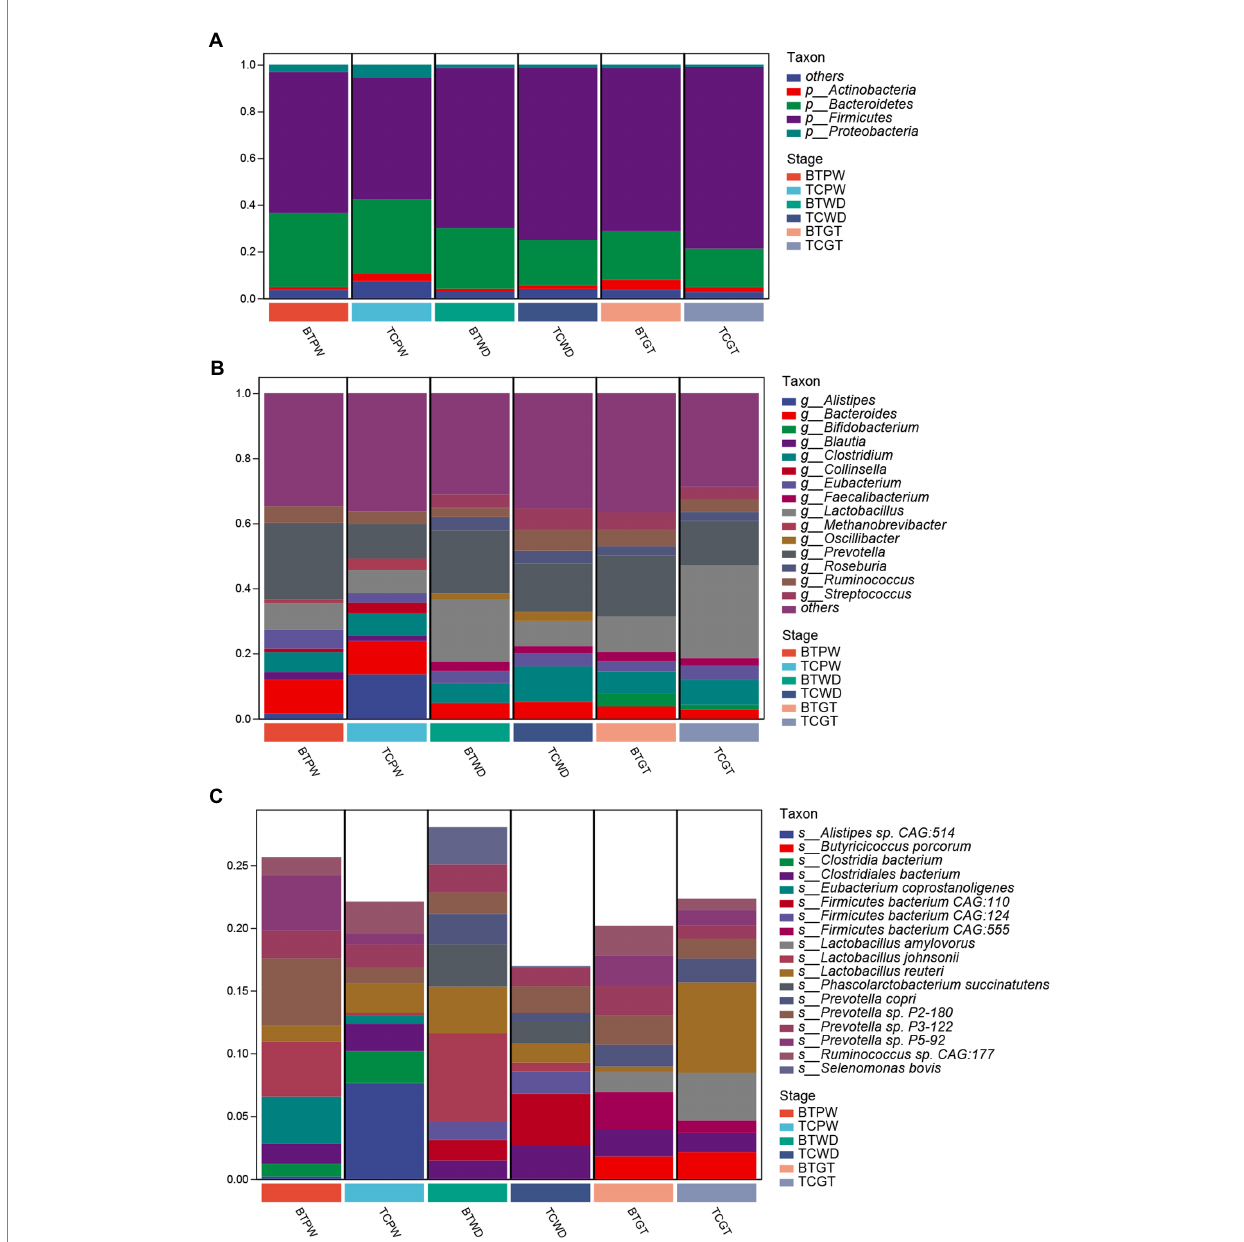
FIGURE 6 Composition and differences of the highly abundant microbial community at different stages in TC pigs and BT pigs. (A) Phylum-level, (B) genus-level, and (C) species-level composition of intestinal microbial communities; each bar shows the average relative abundance of the top 10 microbiota among the